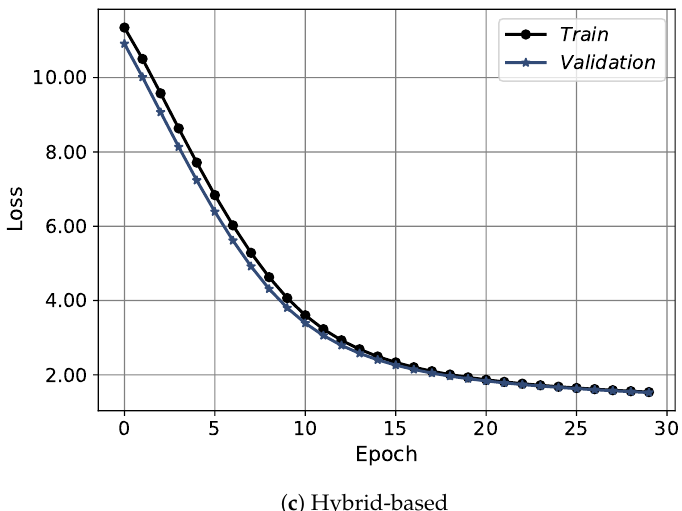
Figure 13. The convergence curves in terms of the loss of the best models for the three approaches of using the spectral features only, the transcript features only, and the hybrid of